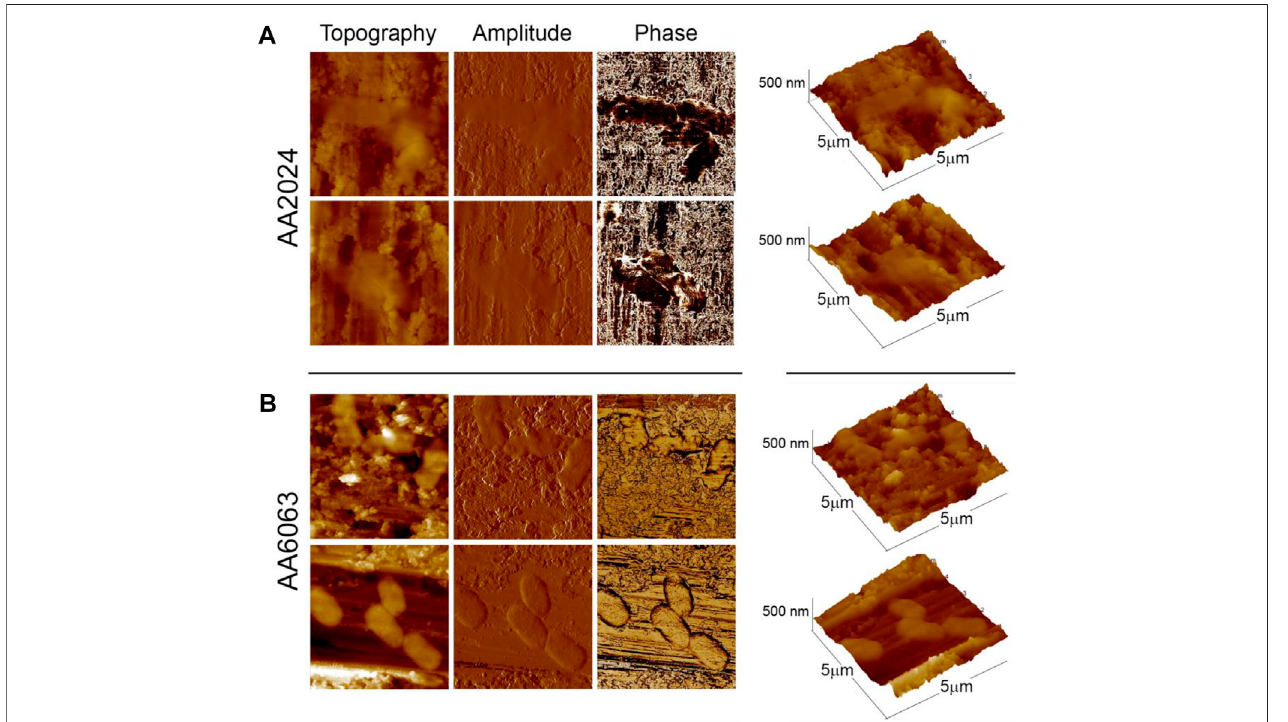
FIGURE 5 | Typical AFM images of bacteria adhered to aluminum alloys surfaces obtained in the tapping mode (Left panels: height, amplitude, and phase, respectively. Rightmost panels: three-dimensional pro fi les of bacteria). (A) Set of images at 2 distinct locations of alloy surface AA 2024 inseminated by P. aeruginosa bacteria. (B) Same for alloy AA 6063. All images were obtained at pH (cid:2) 7.5.